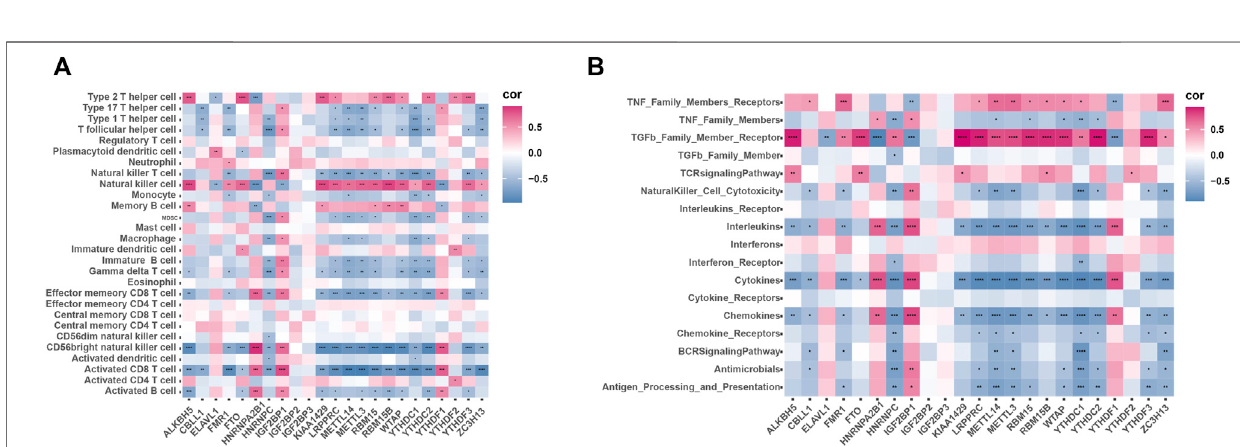
FIGURE 5 | LASSO regression modeling. (A,B) LASSO regression modeling m6A gene. (C) scoring boxplot. (D) diagnostic Nomo plot.